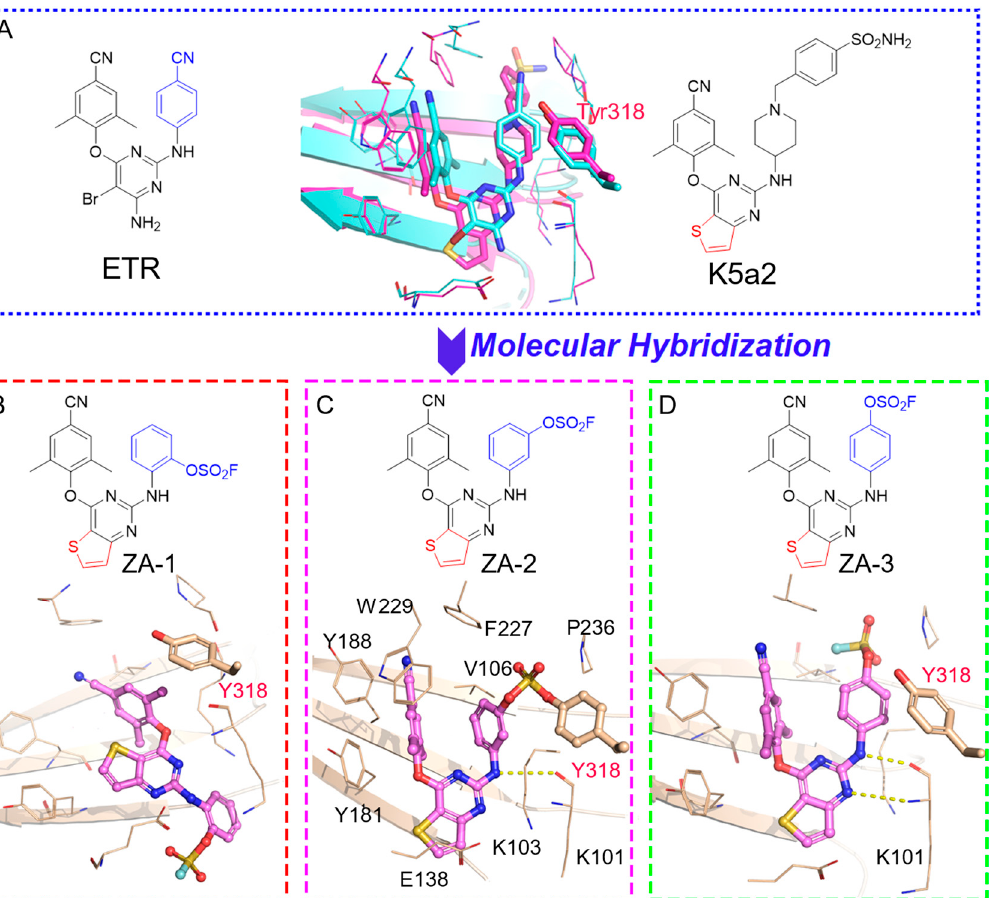
Figure 2. Design of the novel covalent inhibitors ( A ) and predicted binding modes of ZA-1 ( B ), ZA-2 ( C ), and ZA-3 ( D ) with the HIV-1 WT RT (PDB code: 3MEC) [11]. All hydrogen bonds are shown as yellow dotted lines. Nonpolar hydrogen atoms are not shown for clarity.